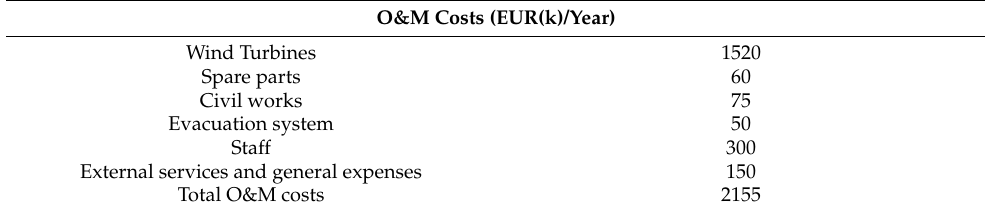
Table 3. Operation and maintenance (O&M) costs of the hybrid system.